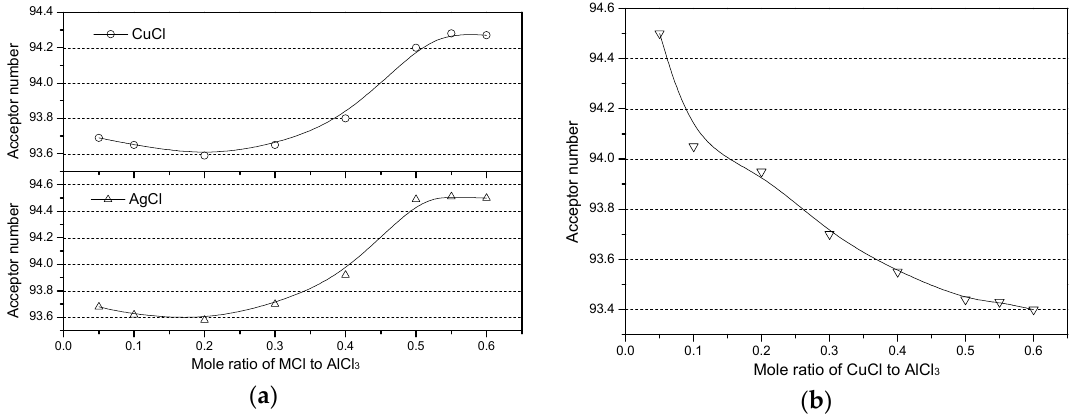
Figure 3. Effects of MCl on the acidity of the chloroaluminate IL: ( a ) adding MCl (M = Cu, Ag) into [(C 2 H 5 ) 3 NH]Cl − AlCl 3 ; ( b ) adding CuCl into [Bmim]Cl − AlCl 3